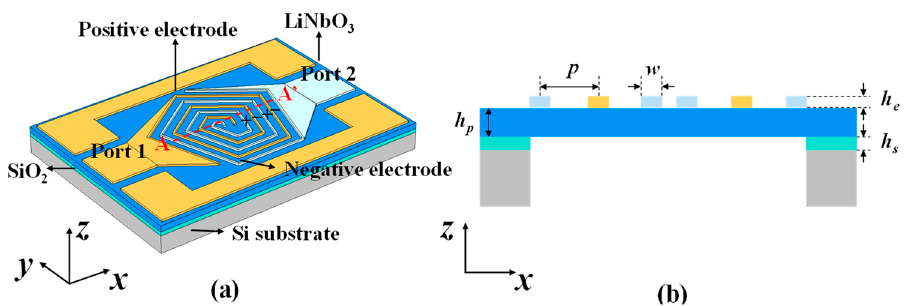
Figure 3. ( a ) Schematic drawing of XBAR with pentagon spiral shape electrode. ( b ) The A-A’ cross-section view of the resonator.